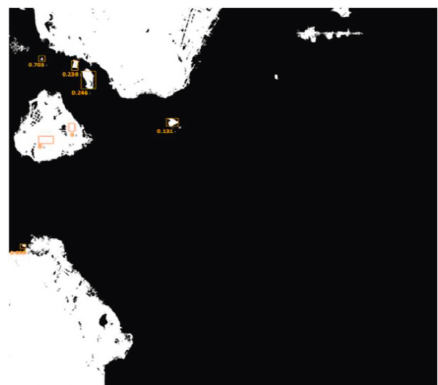
Figure 22: Fine detection result with sea-land